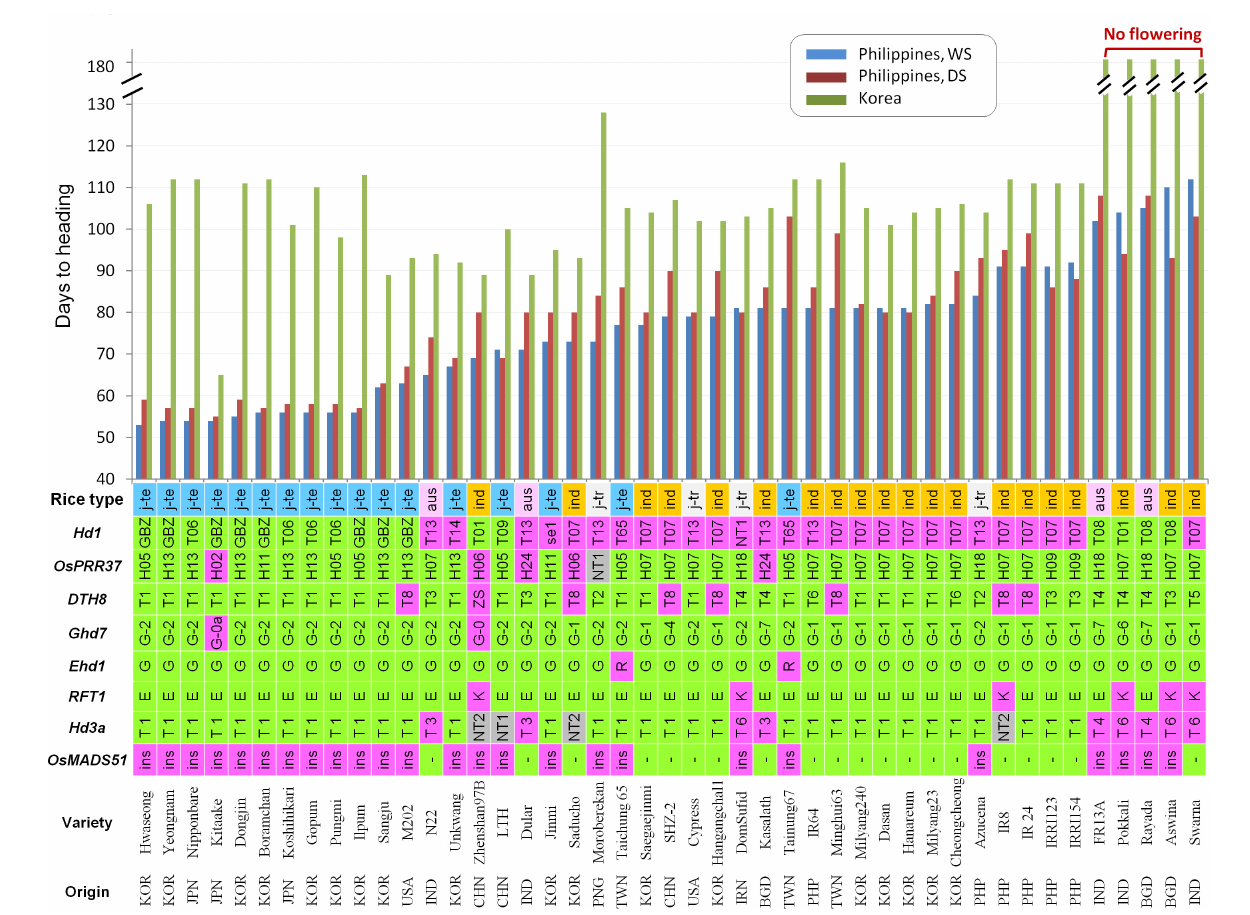
FIGURE 3 | Days to heading (DTH) and the allele types of the major seven heading date genes from 45 diverse accessions. DTH was observed in the three different environments and the samples were sorted by DTH from early to late heading at the IRRI field in the wet season. In the cases of the Ehd1 and RFT1 , the FNPs are presented with the corresponding amino acid (G221R of Ehd1 and E105K of RFT1). The tolerance allele to high temperature-induced flowering caused by 9.5-kb insertion at 1 st intron of OsMADS51 is presented by ‘ins.’ The allele types with their functionality to each gene are depicted (green: functional allele and pink: non-functional allele). In the case of the Hd3a promoter, Group A and Group B are colored with green and pink, respectively, according to the previous research (Takahashi et al., 2009). New allele types (NT) with unknown functionality are shown with gray color. j-te, temperate japonica ; j-tr, tropical japonica ; ind, indica